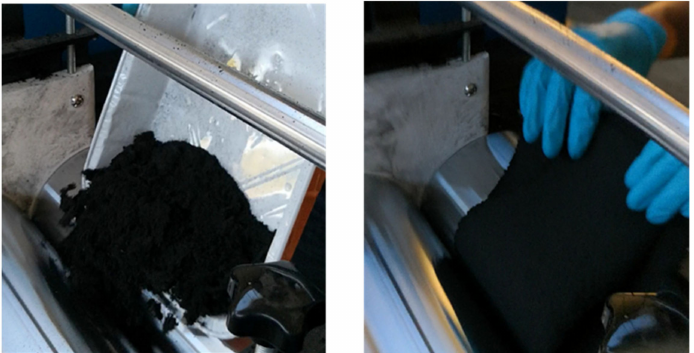
Figure 1. During the calendering process ELT powder (beginning of the process) is transformed into a compound (end of the process, after about 1